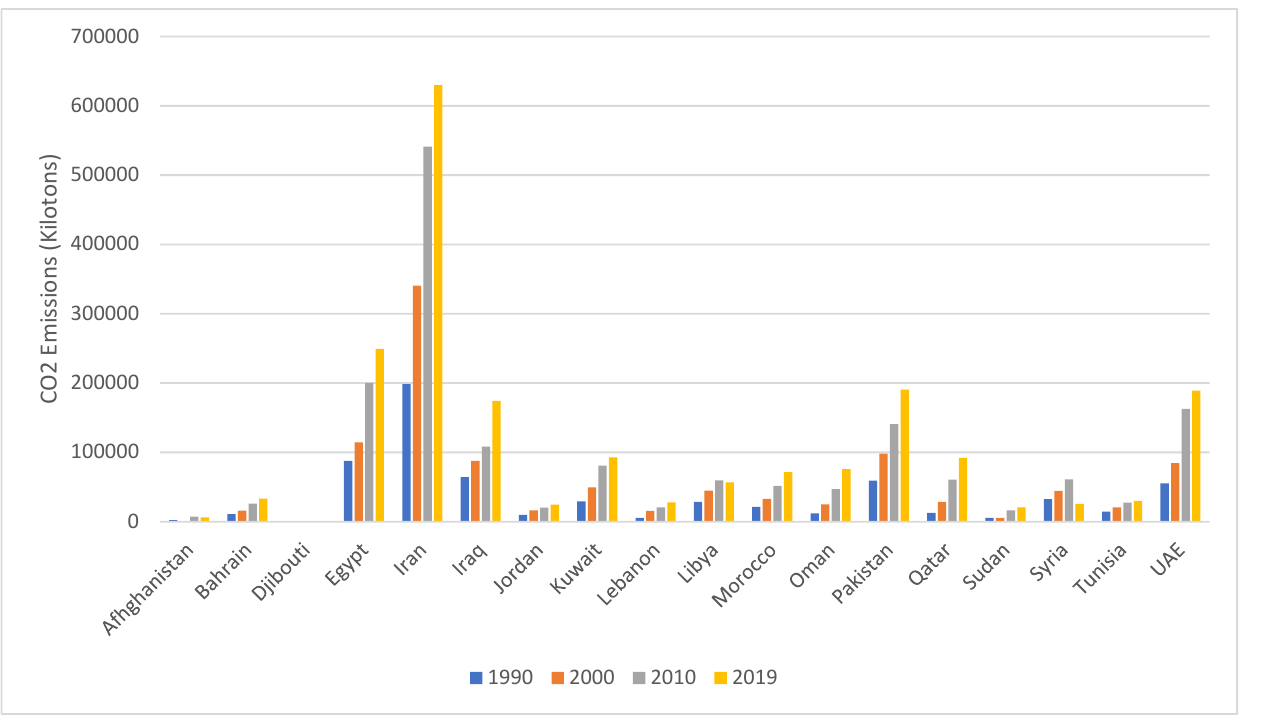
Figure 3. Trend in CO 2 emission (kilotons) over time in countries of the EMR. Data retrieved from the World Bank [9,19,61–76]. Abbreviations: EMR: Eastern Mediterranean Region; UAE: United Arab Emirates.